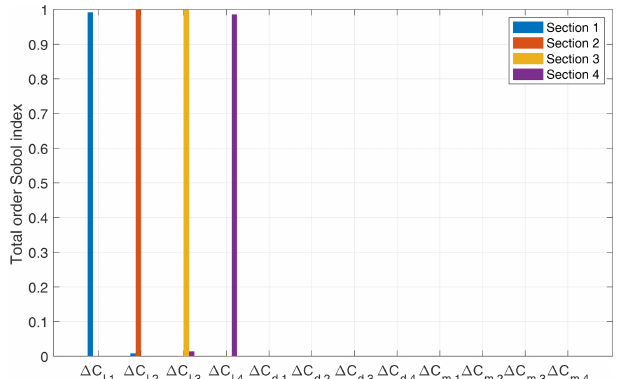
Figure 6. Sensitivity of sectional normal force with respect to per- turbations in airfoil polars with adapted